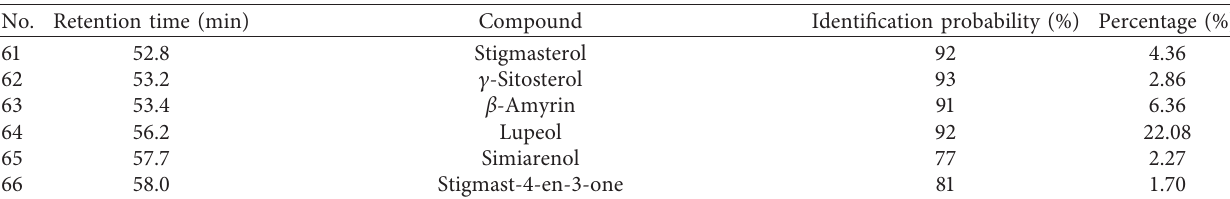
Table 2: The results of chromatographic analysis of Portulaca oleracea ’s CO No. Retention time